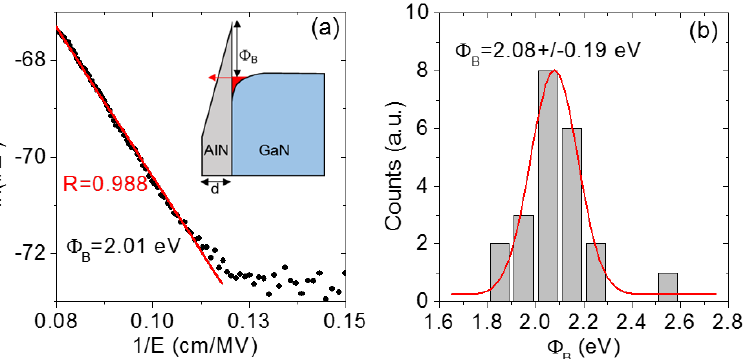
Figure 7. ( a ) Fowler–Nordheim plot of a forward bias I–V curve measured on AlN (5nm)/GaN and results of the linear fit. The schematic band-diagram of the heterostructure under forward polarization is reported in the insert. ( b ) Histogram of the barrier height values obtained by fitting of the I – V curves acquired at different surface positions.